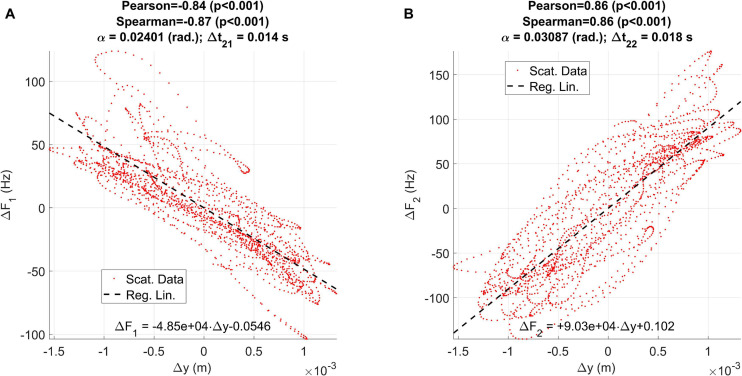
Regression plots between the vertical displacement estimated from accelerometry (Δy) and the first two formant unbiased oscillations: (A) relative to ΔF1; (B) relative to ΔF2.